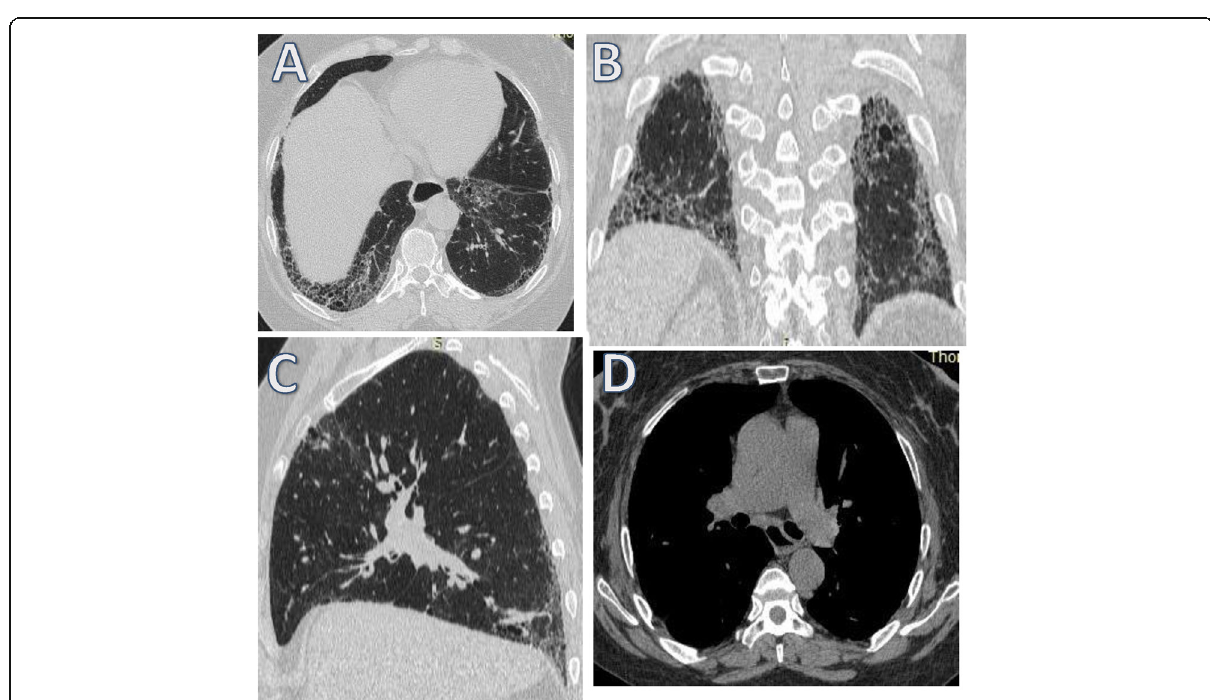
Fig. 2 A 43-year-old female patient presenting with progressive dyspnea. a – c Axial, coronal and sagittal reformatted images of HRCT chest (lung window) showing bilateral fairly symmetrical predominantly basal and subpleural ground glass opacification, thickening of interlobular, and intralobular septae with traction bronchiectasis and bronchiolectasis mounting to honeycombing. d Axial mediastinal window showing prominent main pulmonary artery and patulous esophagus showing air fluid level; findings impressive of interstitial lung disease (ILD) in the form of usual interstitial pneumonia (UIP)